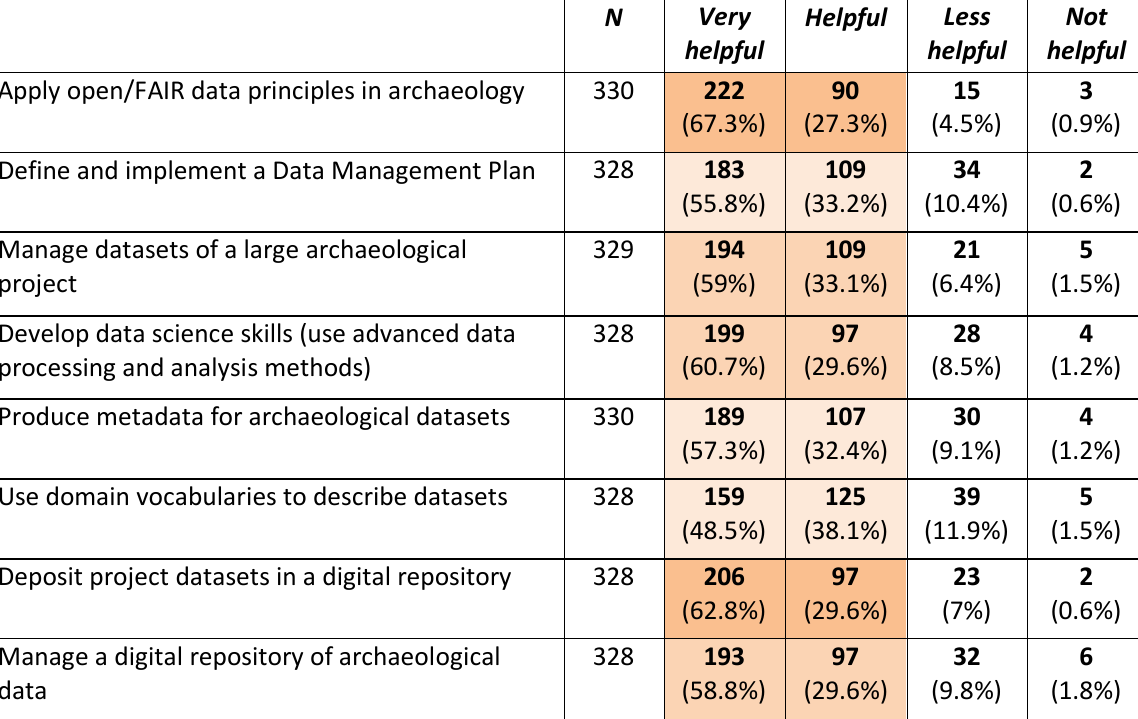
Table 23 : Results for training needs of archaeologists regarding data management and processing (N =